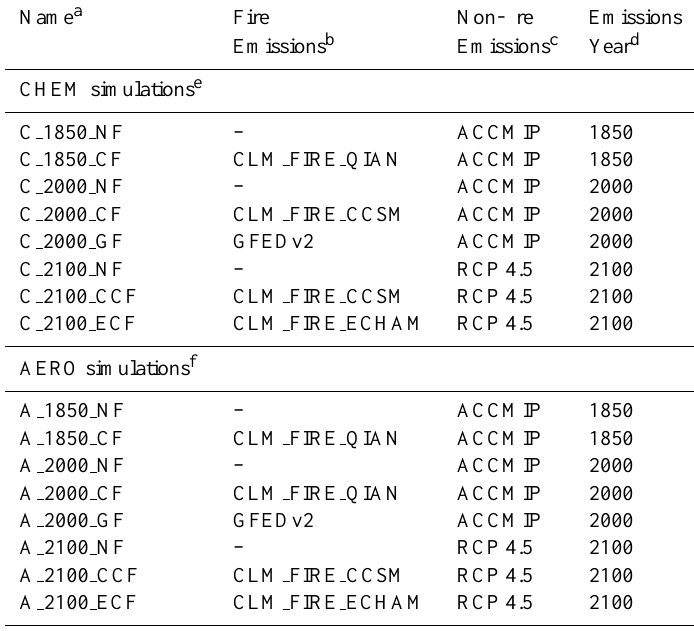
Table 1. Community Atmosphere Model (CAM) simulations analyzed in this